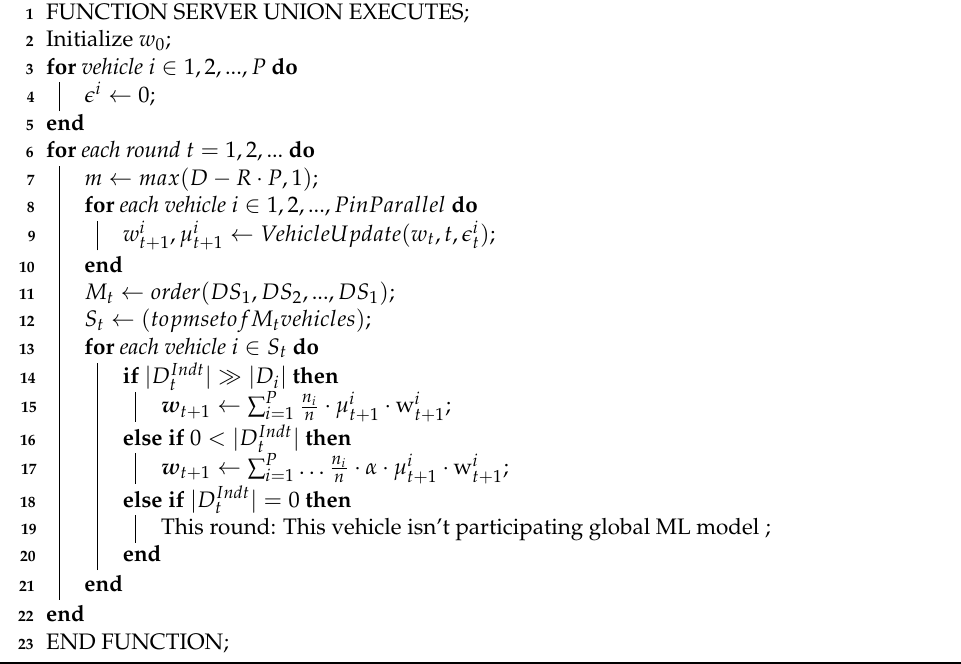
Algorithm 1: Central Server-Vehicle Federated Incremental Learning